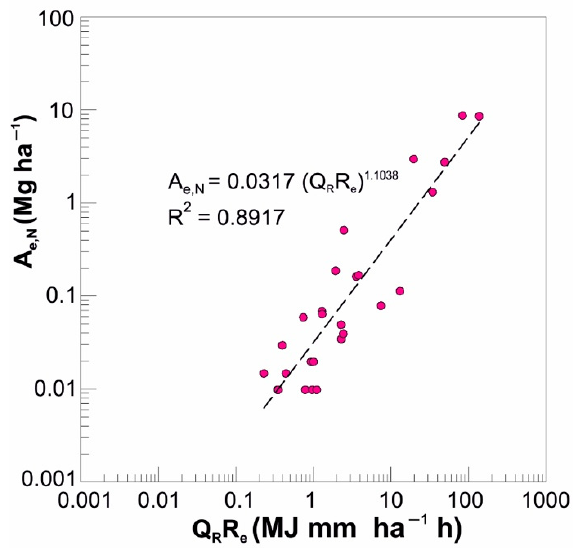
Figure 4. Scatter plots of the measured pairs (Q R R e , A e,N ) and USLE-MM model (equation in the graph) for the data set given in Table S1.